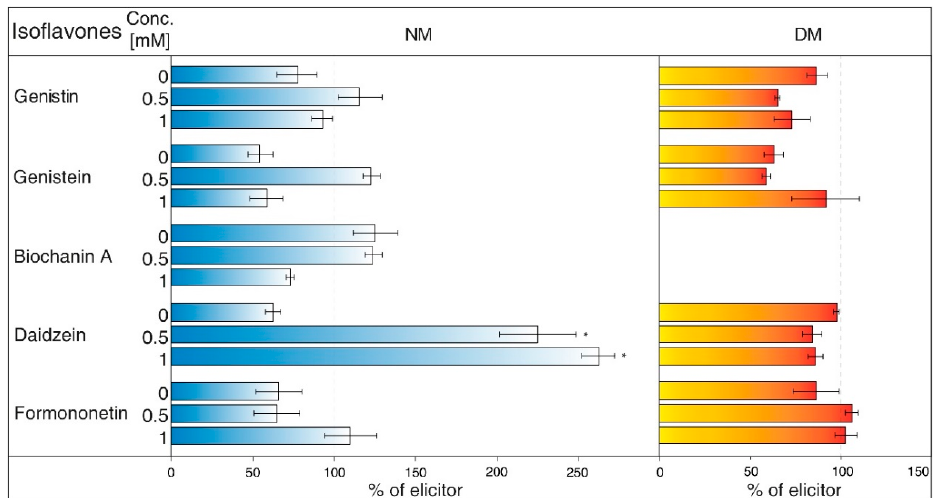
Figure 8. Effects of glibenclamide on isoflavone content in nutrient medium (NM) and dry matter (DM) of Genista tinctoria cell culture. Zero concentration of inhibitor represents water control. All bar values were recalculated to a relative 100% isoflavone content in samples with NH 4 VO 3 (1 μ M) after 24 h. Data are mean of three repeats ± SE; (*) represent significant difference ( p < 0.05) between elicited and inhibited or water control samples within Tukey’s test.